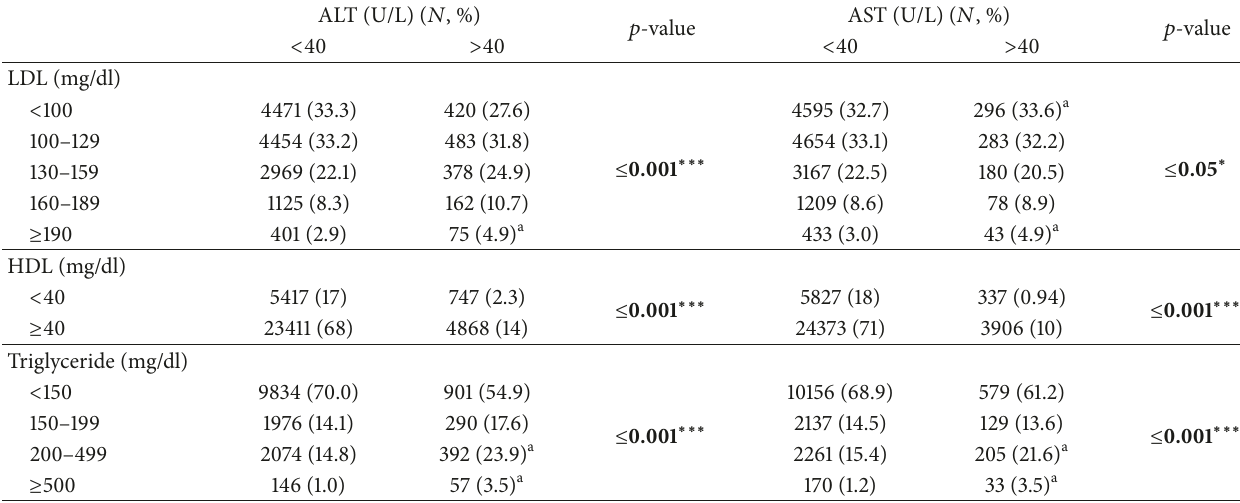
Table 4: Association of lipid markers and liver enzymes (overall